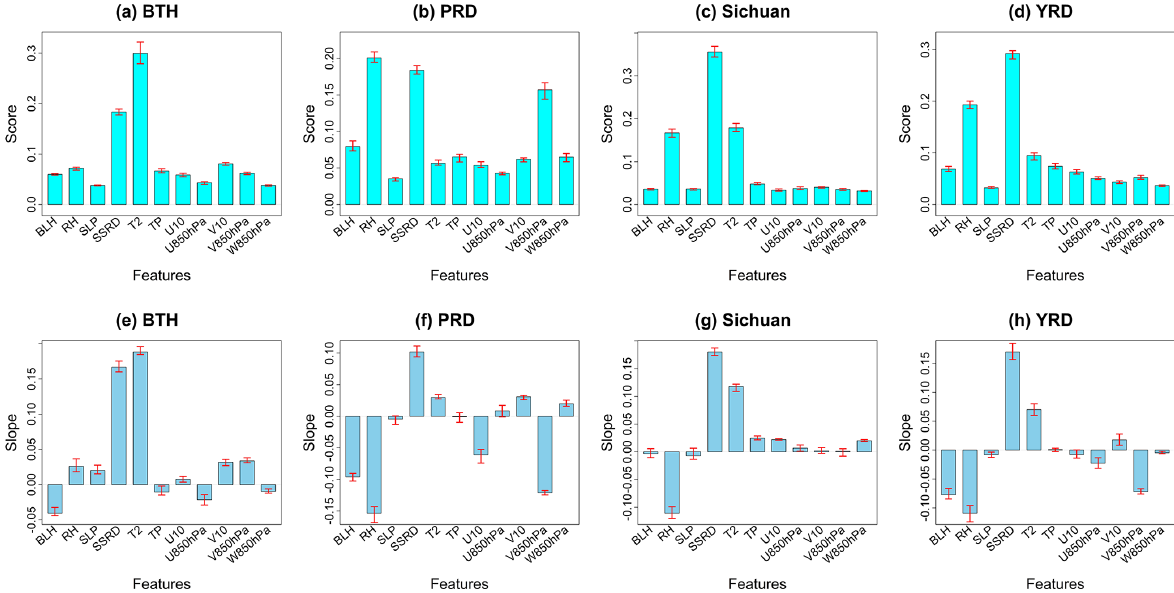
Figure 5. (a–d) Average Gini feature importance scores of each meteorological variable for RFR in each region. (e–h) Average slopes of each meteorological variable for RR in each region. The red bars indicate the range of importance scores/slopes found across the five regression models learned to predict the left-out test